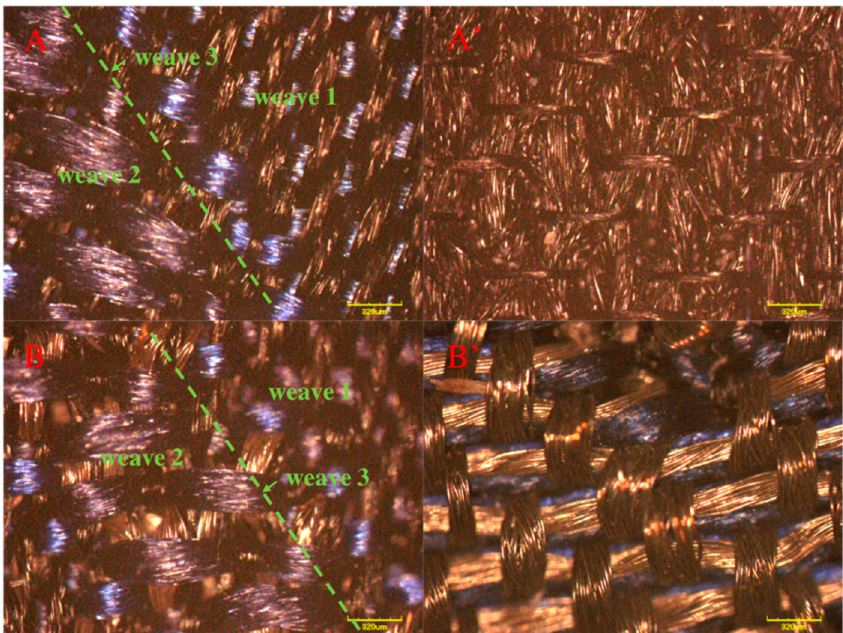
Figure 4. Morphology of the two Song Brocade fabrics from SEM (( A , A’ ): the front side and back side of sample S1; ( B , B’ ): the front side and back side of sample S2).